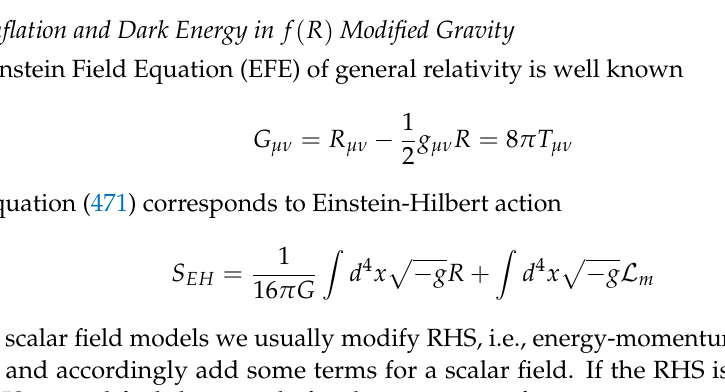
Figure 20. Plot of data for Λ CDM form SNe Ia, CMB, and BAO between Ω Λ and Ω m